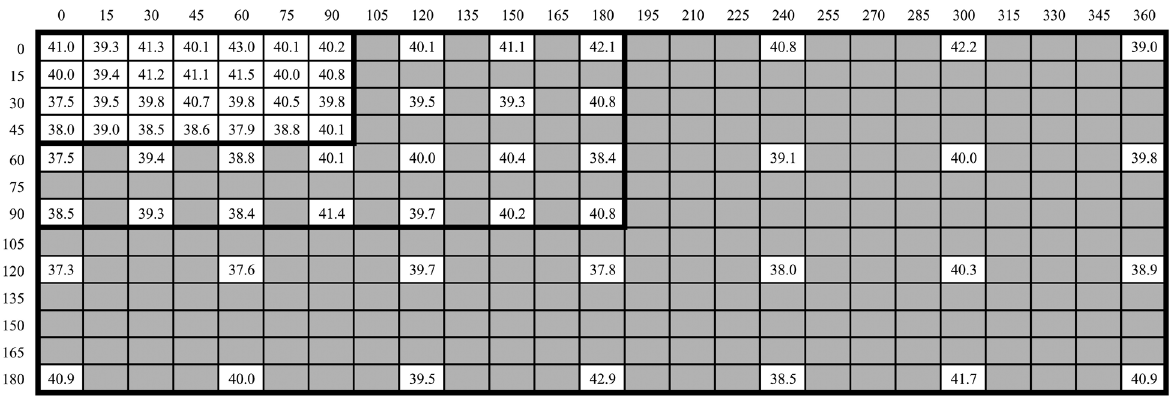
Fig. 1. Arrangement of the testing locations together with the average values of the rebound indices for the L-type original Schmidt rebound